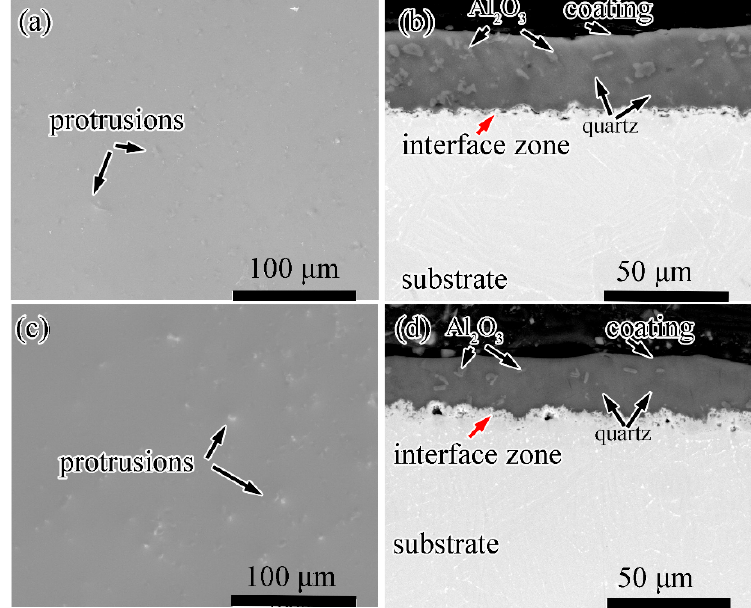
Figure 6. Surface and cross-sectional morphology of the Ti60 with composite coating after oxidation at ( a , b ) 800 °C and ( c , d ) 900 °C for 100 h.